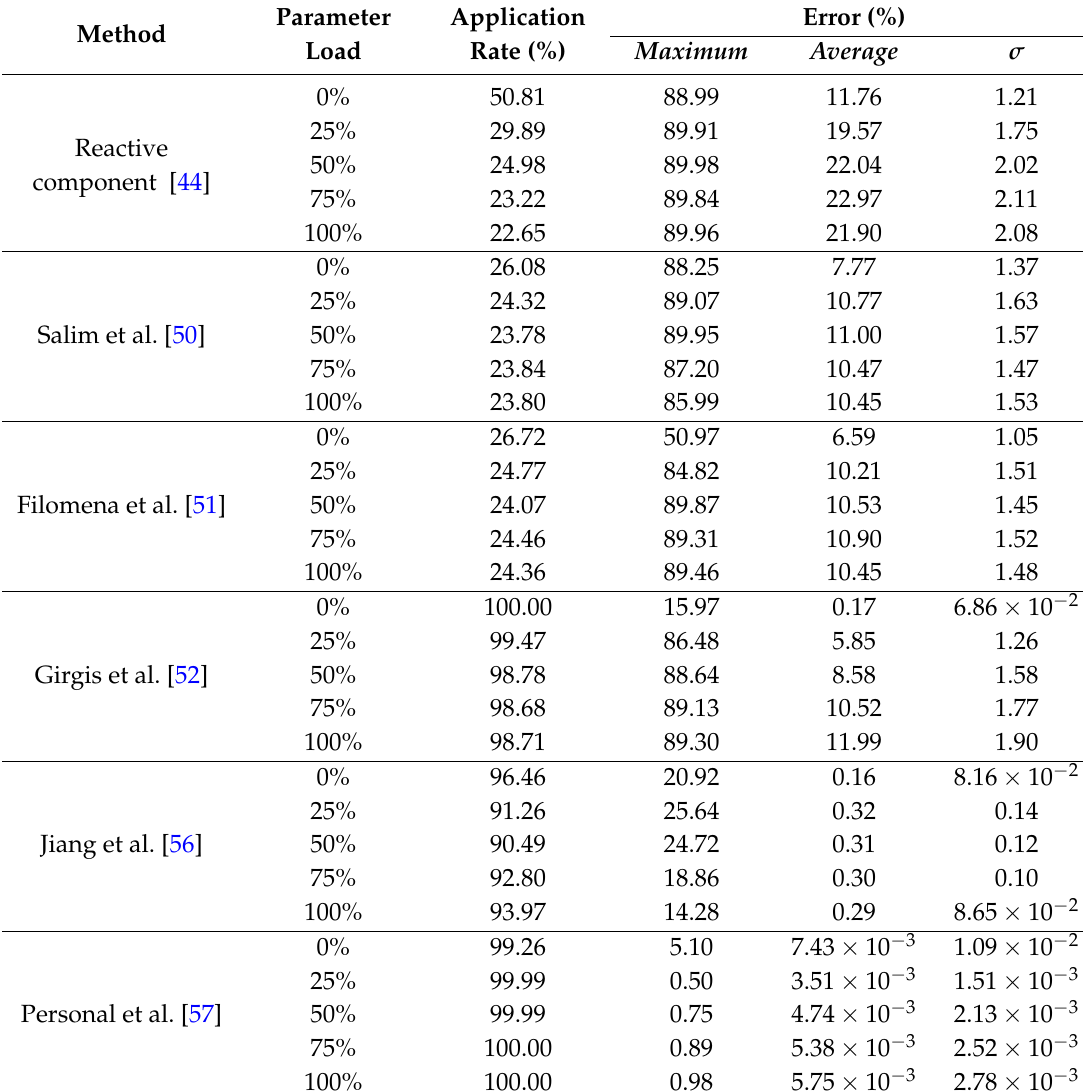
Table A7. Applied load percentage